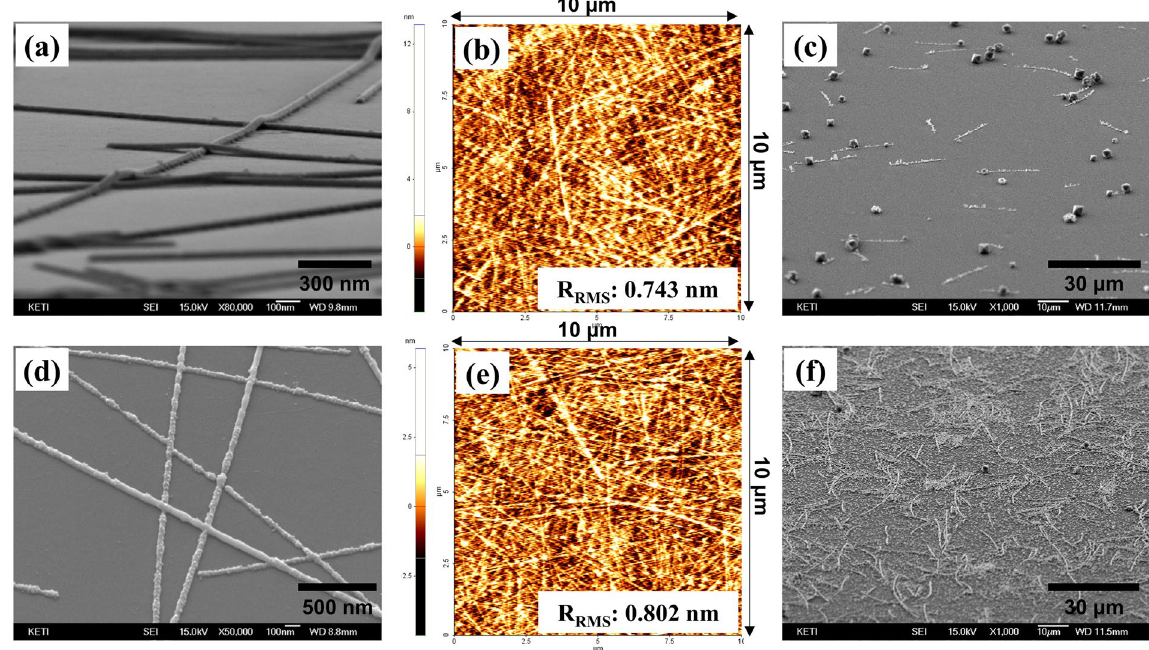
Figure 2. ( a ) SEM micrograph of AgNWs on a glass substrate without an Ar plasma treatment, ( b ) AFM surface micrograph of an untreated AgNWs/cPI electrode, ( c ) SEM micrograph of the untreated AgNWs/ cPI electrode after immersion into a Cu plating solution, ( d ) SEM micrograph of AgNWs on a glass substrate after an Ar plasma treatment, ( e ) AFM surface micrograph of a treated AgNWs/cPI electrode, and ( f ) SEM micrograph of the treated AgNWs/cPI electrode after immersion into a Cu plating